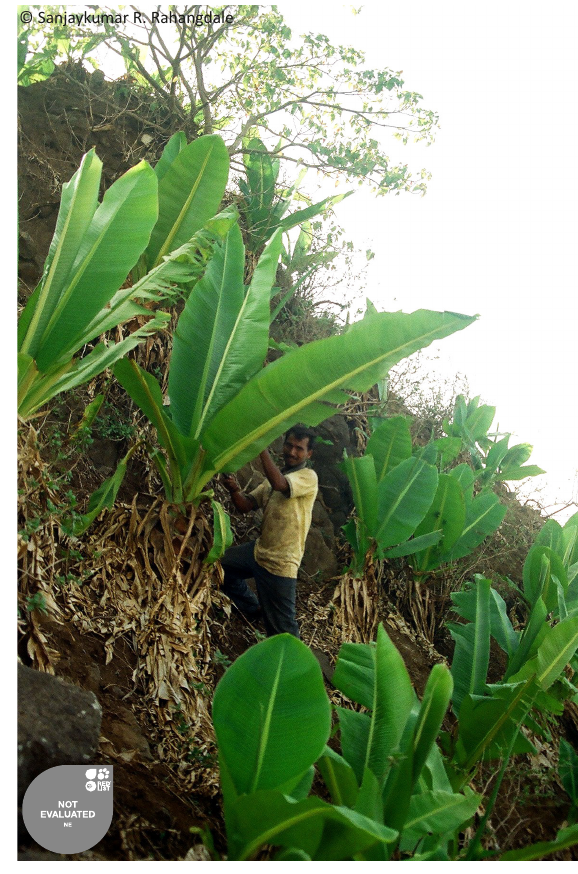
Image 1. Ensete superbum - Leaf